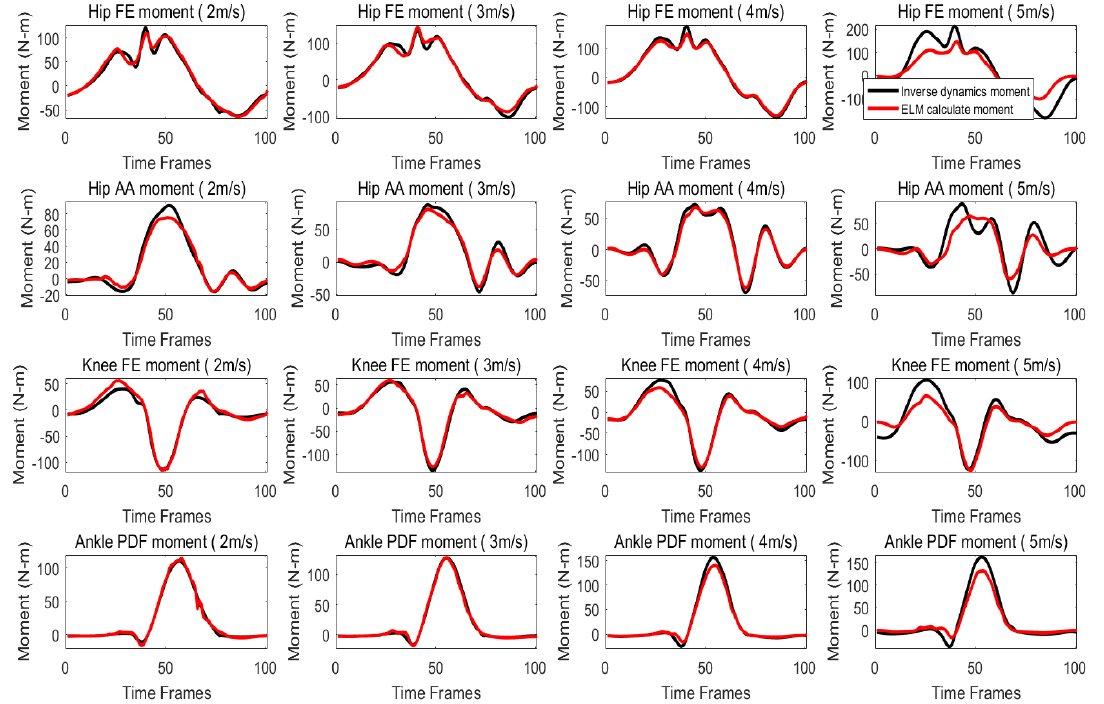
Figure 6. Joint moment prediction of a typical subject at each speed when only the three low speeds are used for training (level 2). Table 3. Joint moment prediction performances for level 2, evaluated by VAF (%).